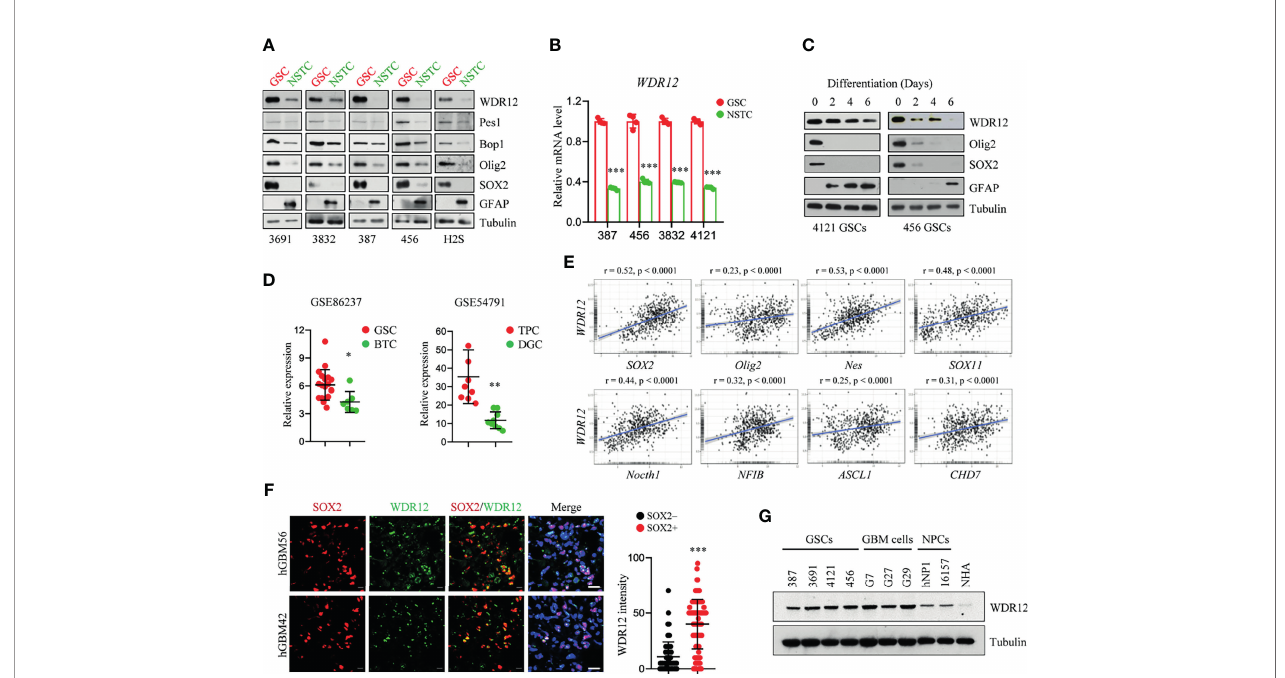
FIGURE 1 | WDR12 is preferentially upregulated in Glioma Stem-like Cells. (A) Immunoblot (IB) showing the expression of WDR12, Pes1, Bop1, SOX2, Olig2, GFAP, and GAPDH in GSCs and matched NSTCs. (B) Relative mRNA expression of WDR12 was analyzed by qRT-PCR in GSCs and matched NSTCs. (C) IB analysis the expression of WDR12, SOX2, Olig2, and GFAP during serum-induced GSC differentiation. (D) Relative mRNA expression of WDR12 in GSCs (n=19) relative to bulk tumor cells (BTCs, n=7) from GEO pro fi le (GSE86237, left), and in tumor propagating cells (TPCs, n=9) relative to differentiated glioma cells (DGCs, n=9) from GEO pro fi le (GSE54791, right) are shown. (E) Pairwise correlation analysis of the indicated genes in REMBRANT database. Pearson correlation coef fi cient (r) value and P value are shown. (F) Representative immuno fl ourescent images of human primary GBM specimens stained with anti-WDR12 (green) and anti-SOX2 (red). Nuclei were counterstained with Hoechst (blue) (left). Scale bars, 20 m m. Quanti fi cations of WDR12 staining intensity in SOX2+ (n=113) and SOX2- (n=130) cells (6 random microscope fi elds from 4 tumors) are shown (right). (G) IB showing the expression of WDR12 and Tubulin in GSCs, isolated primary GBM cells, human neural progenitor cells (hNP1 and 16157) and normal human astrocyte (NHA). Data are represented as mean ± SD. *p < 0.05, **p < 0.01, ***p < 0.001, as assayed by Unpaired Student ’ s t-test or Welch ’ s t